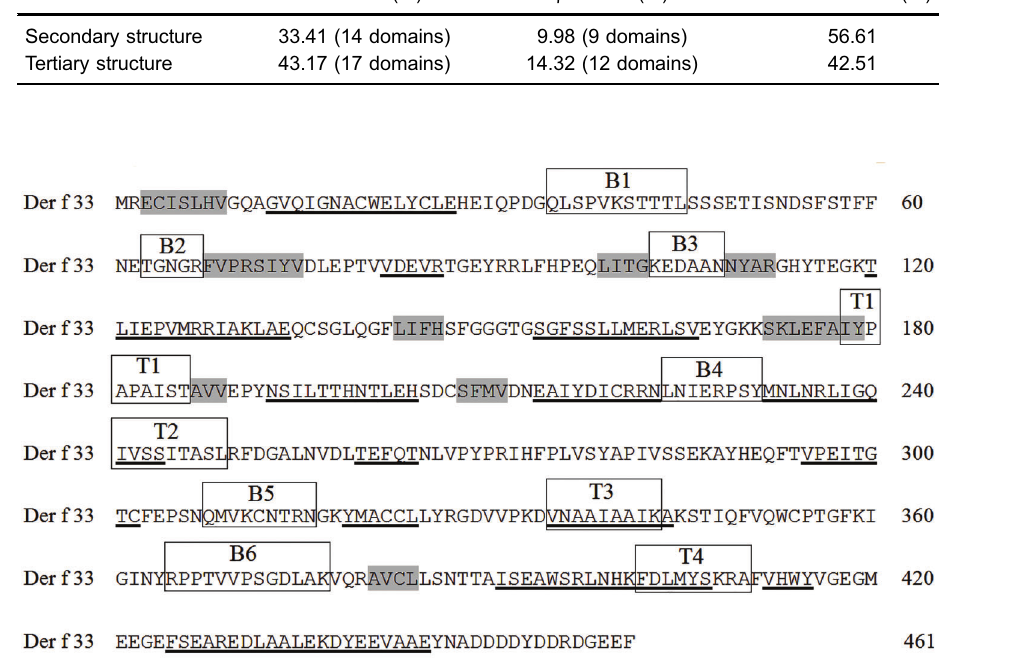
Figure 2. Secondary structure elements for Der f 33. The a -helices are underlined, b -sheets are shown in gray highlight, random coils in unlabeled sequence, and epitopes are within a box.